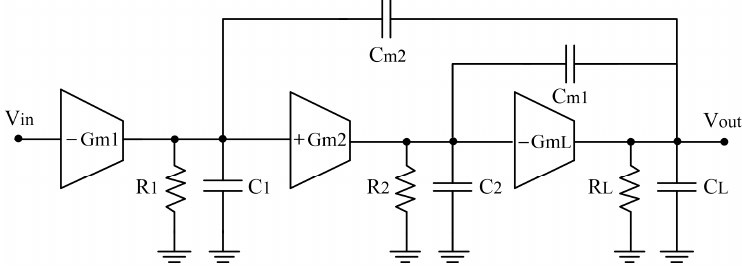
Figure 6. A three-stage ampli fi er in the RCg m model. Table 4. Number of terms within simpli fi ed symbolic poles/zeroes in Circuit 1.